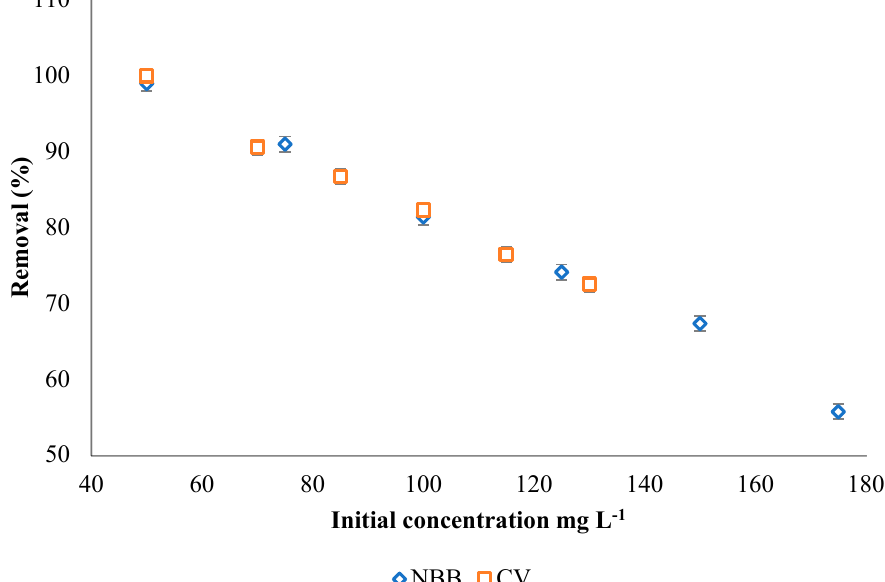
Figure 8. Effect of initial dye concentration of NBB and CV on the adsorption efficiency of ACOC (T = 25 °C, V = 100 mL, m ACOC is 0.050 g for NBB and 0.020 g for CV; contact time is 210 min. for NBB and 120 min. for CV).